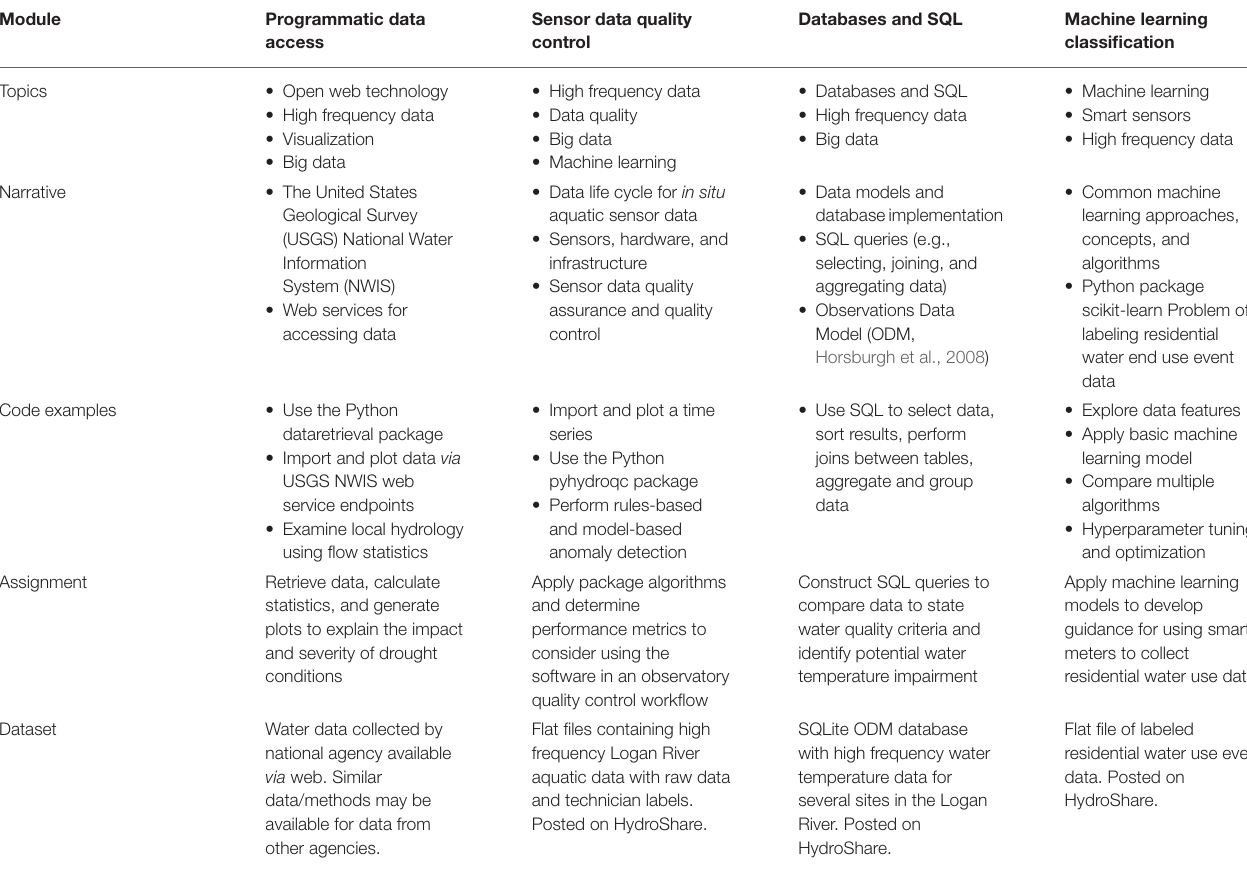
TABLE 5 | Educational modules developed and deployed as part of this work with descriptions of essential components and datasets.